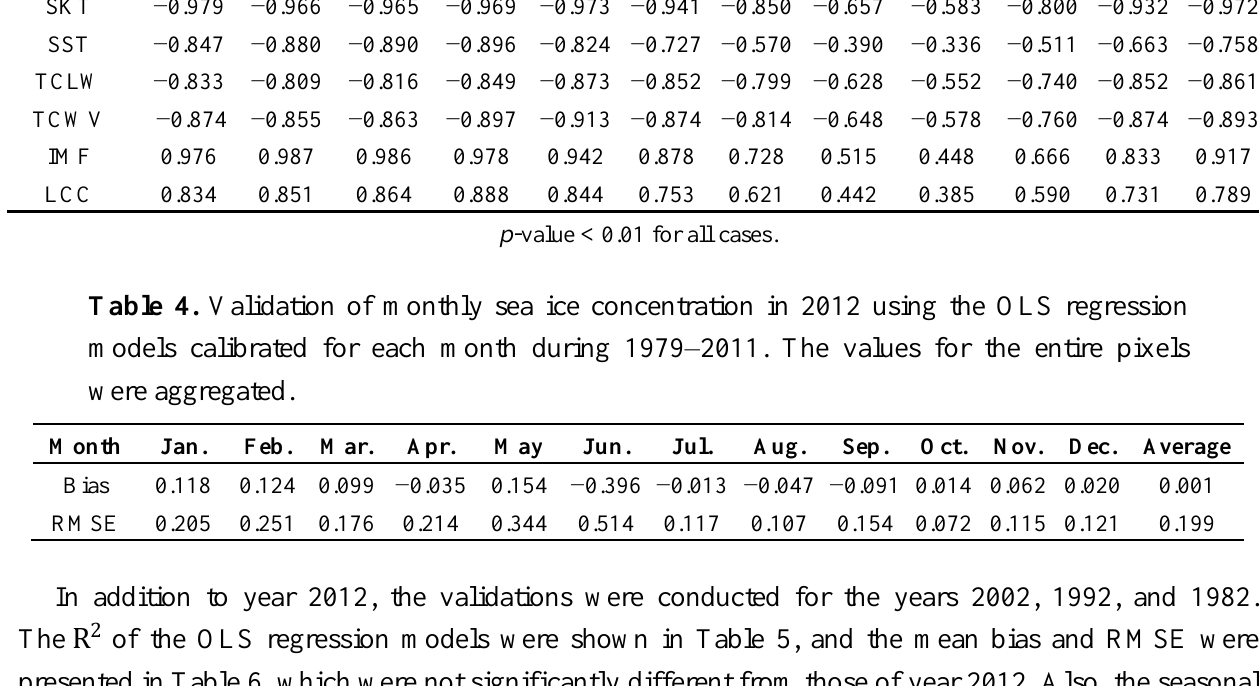
Table 3. Pearson correlation coefficients (R) of the six explanatory variables for the sea ice concentration. They were calculated from the averages of the normalized variables during 1979–2011. Pearson R